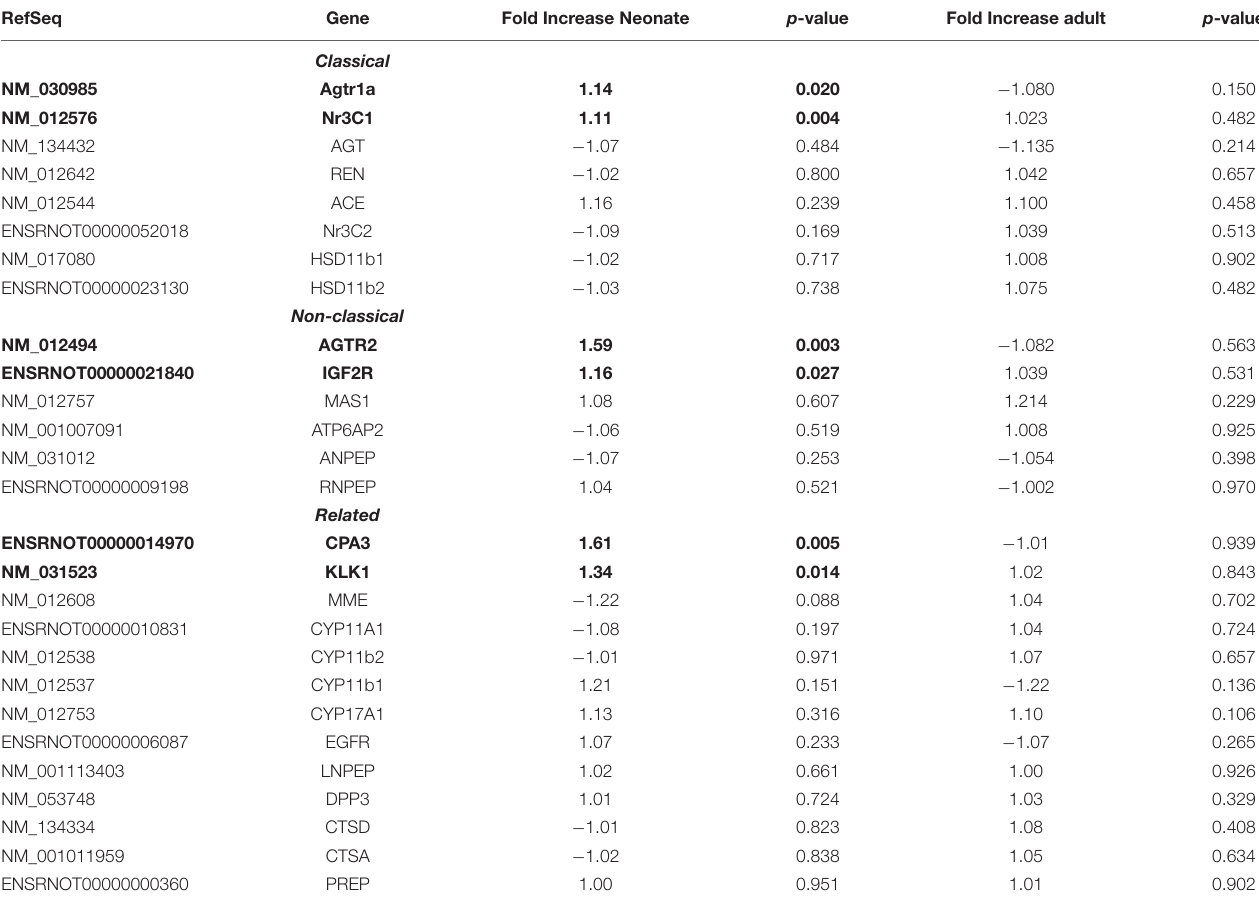
TABLE 1 | Effect of MatSep on RAS gene expression trajectory from neonate-to-adult life. RefSeq Gene Fold Increase Neonate p -value Fold Increase adult p -value